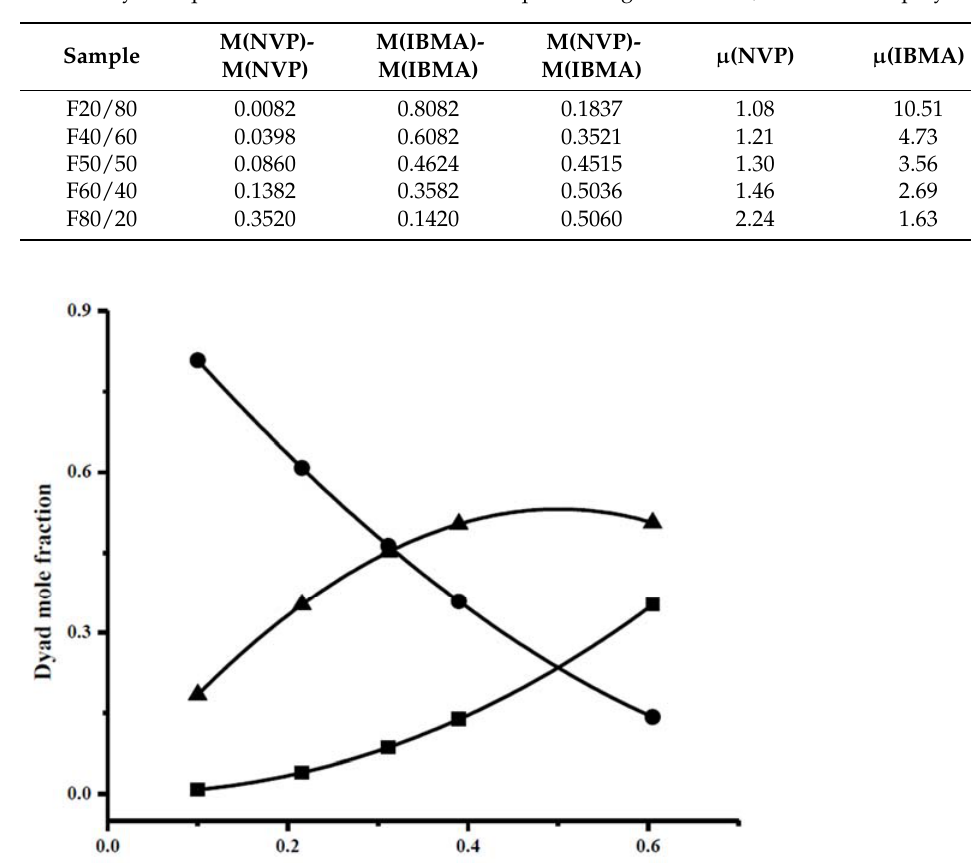
Table 4. Dyad sequence distributions and mean sequence lengths of IBMA, NVP in the copolymers.